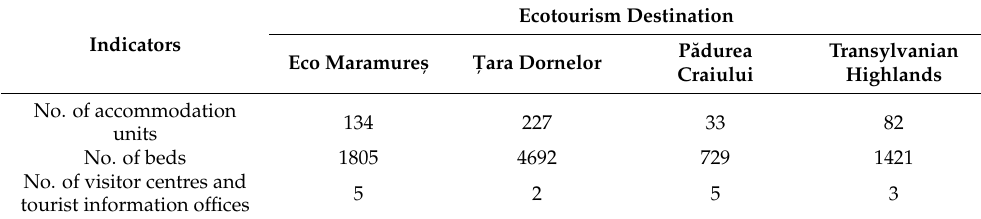
Table 1. Tourism infrastructure within the studied ecotourism